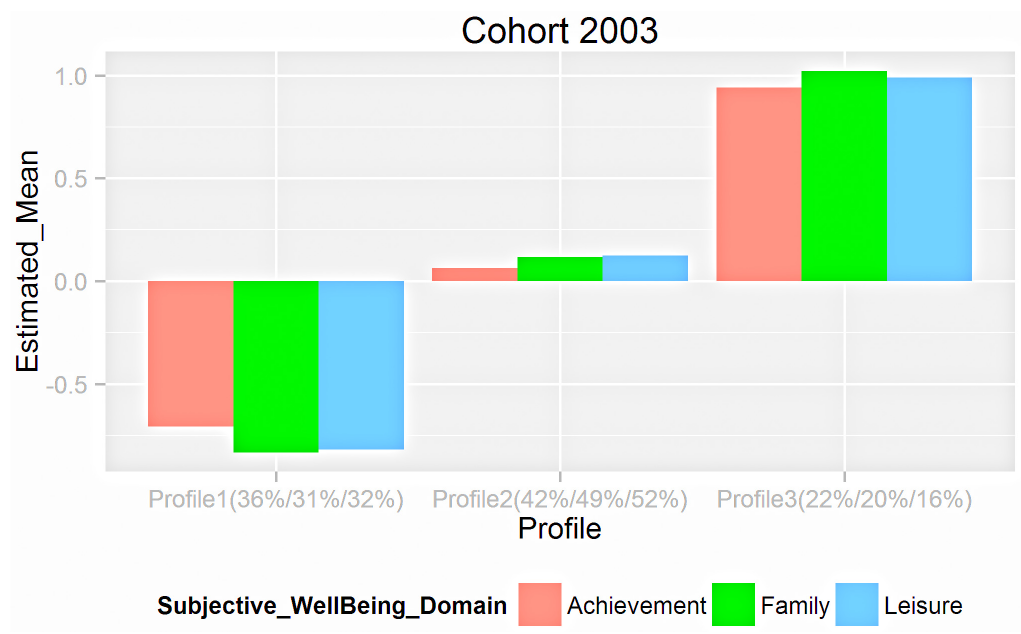
Fig 1. Subjective well-being profiles for Cohort 2003 across time from three-wave latent transition analyses. Fig presented here is based on raw scores. Percentages represent the proportion of population classified into the respective profiles at